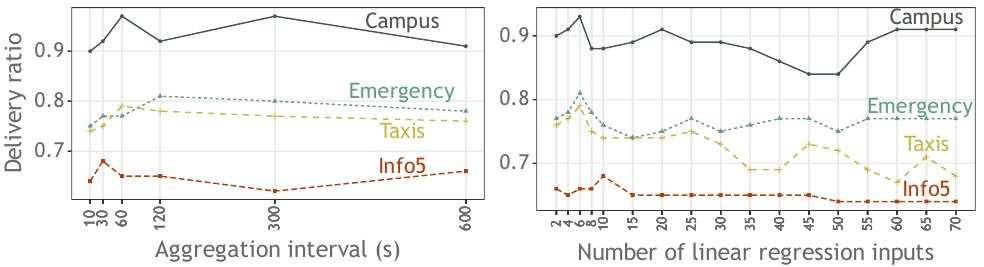
Figure 15. Left: delivery ratio vs. the time interval while the controller is gathering congestion readings. Right: delivery ratio depending on the number of inputs the linear regression is fed